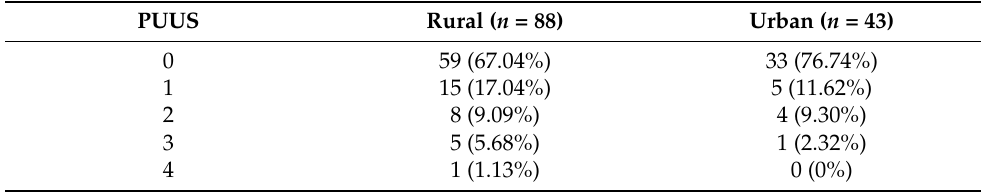
Table 9. Number and proportion of patients for each PUUS value regarding the origin of the parturient.